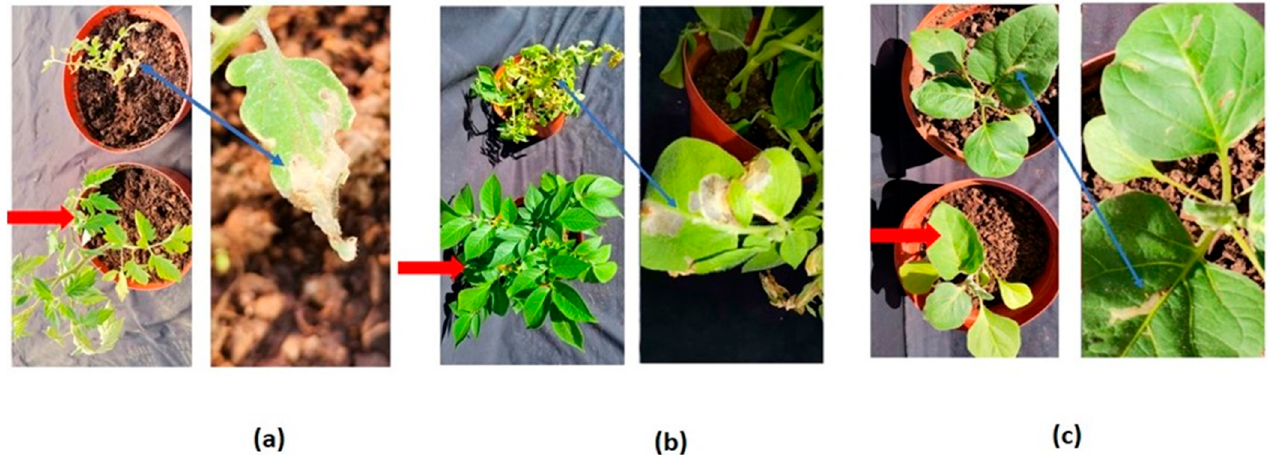
Figure 2. Tomato ( a ), potato ( b ), and eggplant ( c ) infested with Tuta absoluta (indicated with a blue arrow) and uninfested plants (indicated with a red arrow).